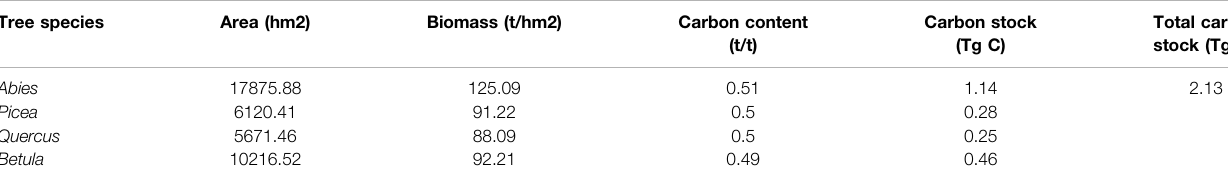
TABLE 6 | Carbon stock potential of the optimal